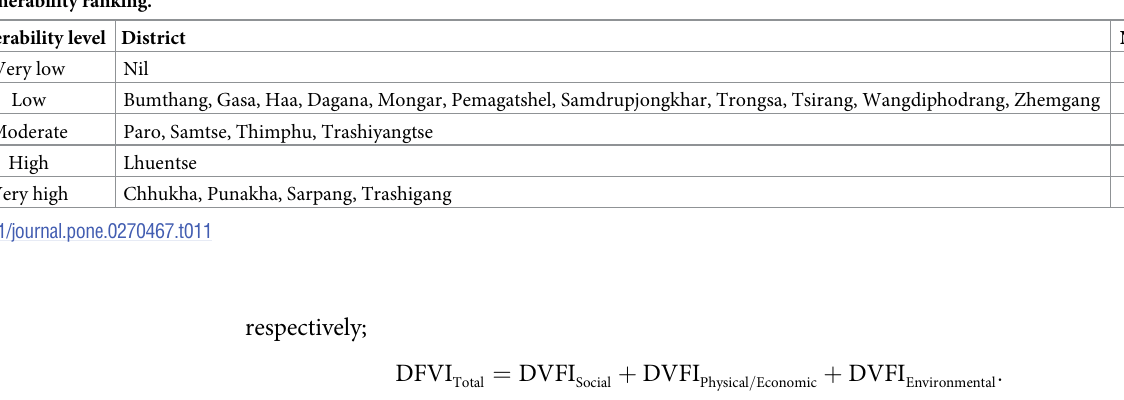
The final obtained DFVI is scaled to define the vulnerability level [21] as presented in Table 11. The scaled vulnerability index provides flood vulnerability designation for each of the districts ranging between 0–0.01 as very low vulnerability to flooding, and 0.75–1.0 as very high vulnerability to flooding, with other intermediate values. The study indicates four districts with very high flood vulnerability, including two in the southern region, and one each in the east and west. One of the districts falls in the category of high vulnerability, another four in the medium category, and 11 districts in the low-flood vulnerability category. Districts with higher DFVI in the east, west and southern region of Bhutan remain constantly vulnerable to floods compared to other districts that are primarily contributed by susceptibility to a high frequency of events and heavy rainfall. As a result of the study, the DFVI map of Bhutan is presented in Fig 9.